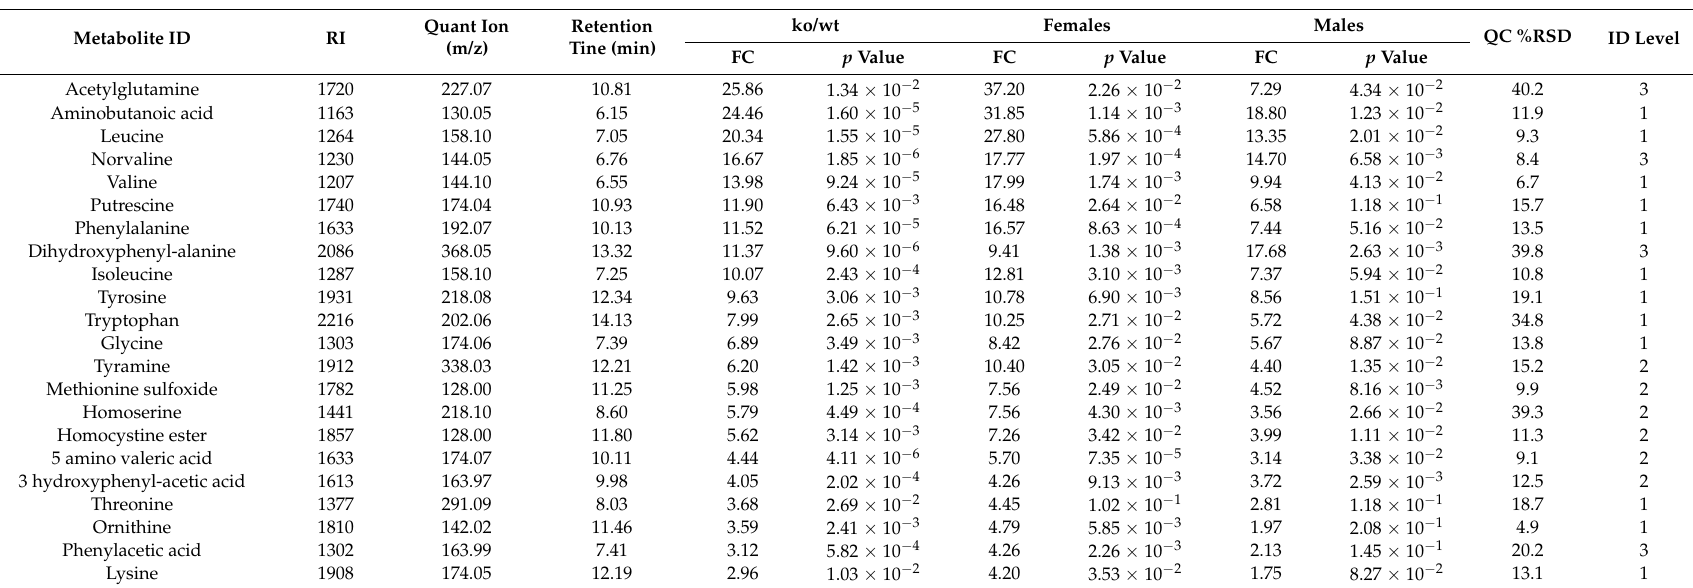
Table 4. Metabolites changes in the faeces of SLC6A19ko and SLC6A19wt